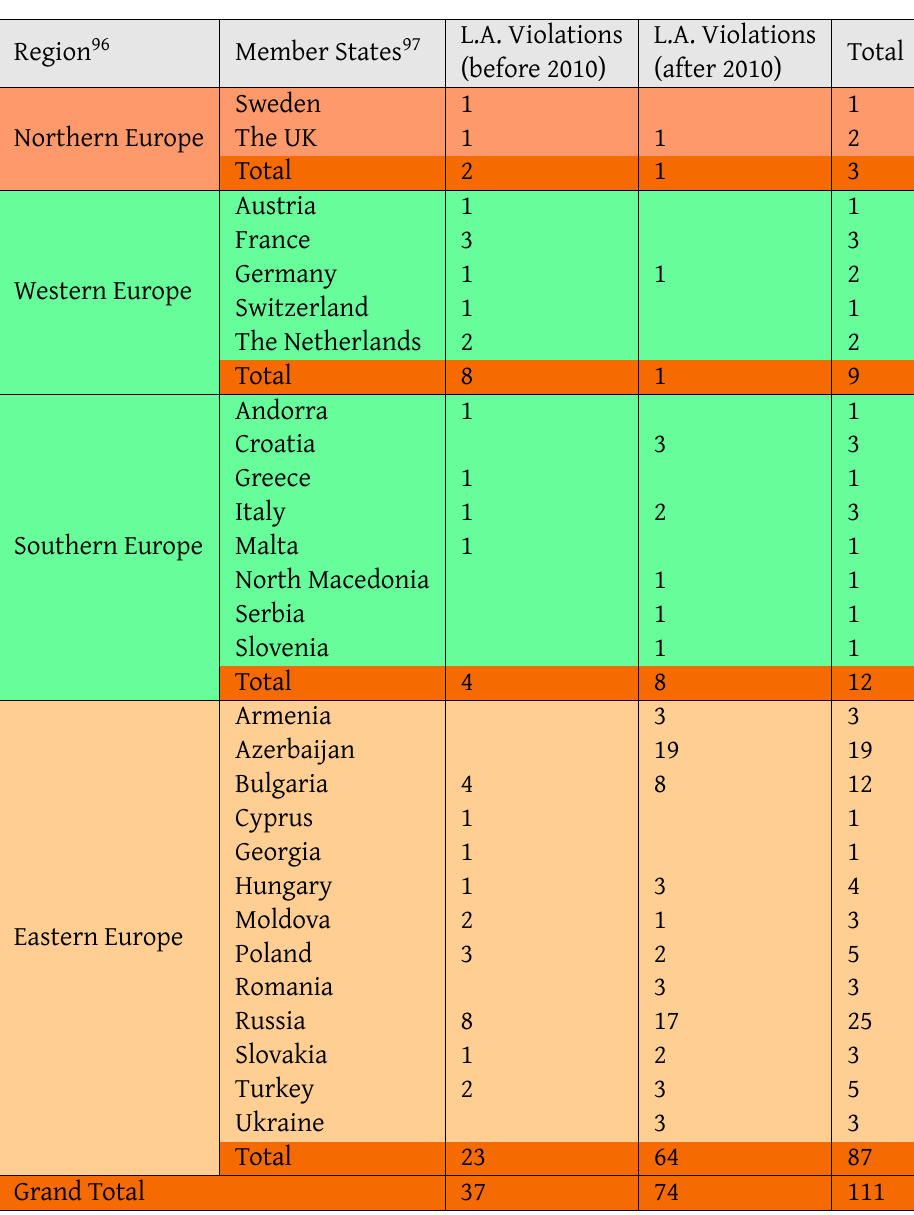
Table I: Dispersion of the L.A. violations over Time, Member States and